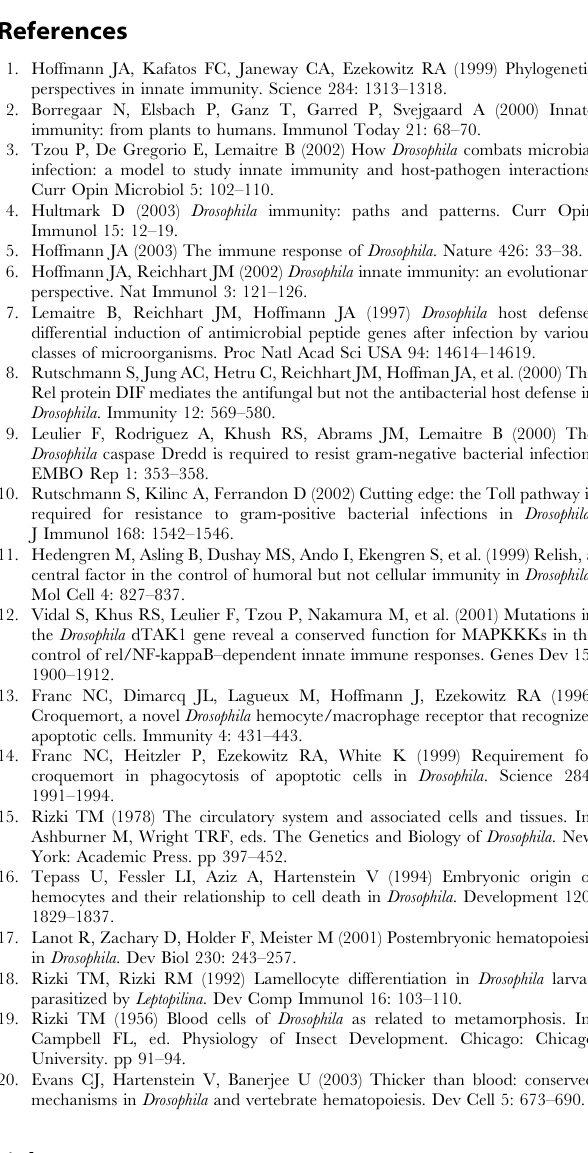
Table S1 P -element insertion lines used and their survival after septic infection of B. bassiana .